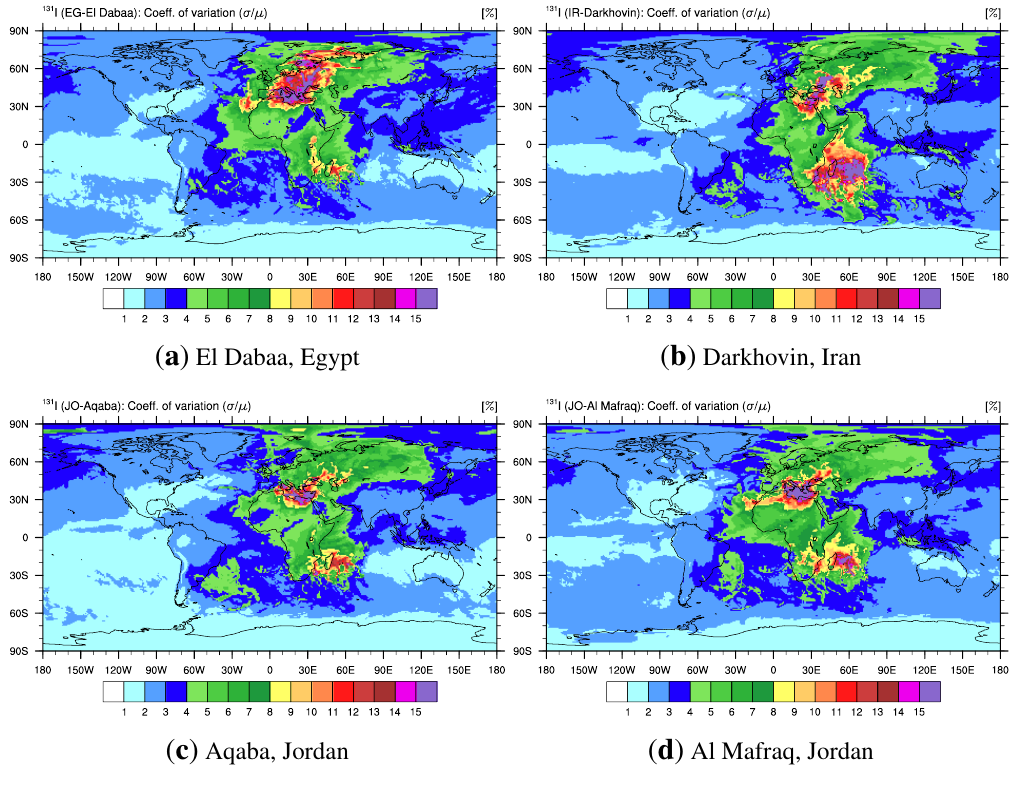
Figure 8. Individual and combined bottom relative risk coefficient of variation ( σ / µ ) for NPPs in the EMME